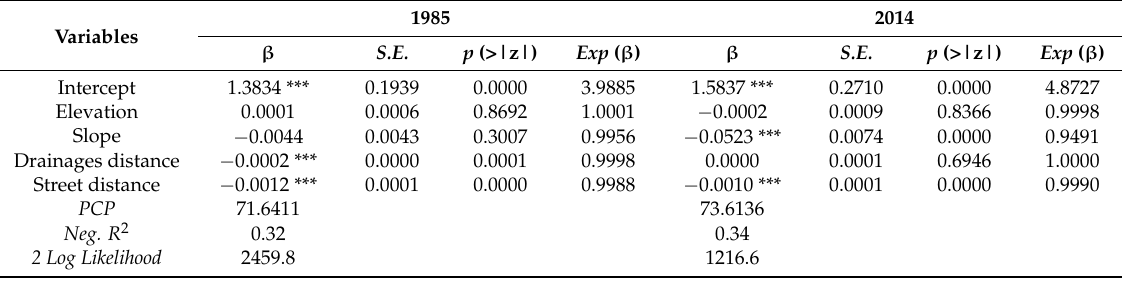
Table 4. Estimated results of the logistic regression model in Makkah of the four independent variables.